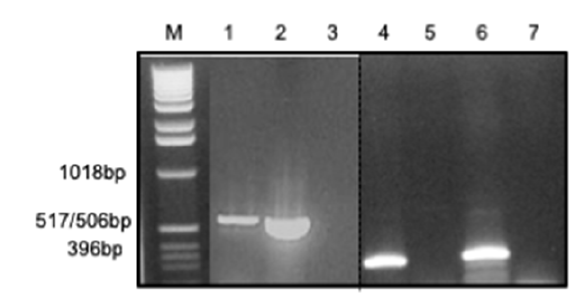
Figure 6. Electrophoresis of RT-PCR products after amplification of liver tissue with specific primers for CNF (left side) or β-actin (right side). M: molecular marker 1 kb DNA ladder (Gibco-BRL). Lanes 1 and 4: B. constrictor liver; lanes 2 and 6: C. d. terrificus liver (reference); lanes 3 and 7: negative control (no DNA); lane 5: no reverse transcriptase in the activity of C. d. terrificus venom by BcNF Figure 5. Inhibition curves of PLA 2 isolated from B. constrictor blood plasma (white dots). CNF from C. d. terrificus snakes was used as positive control for PLA inhibition (black dots). Curve 2 equations: y = (–1.344 ± 0.1705)x + (13.50 ± 0.4235) for BcNF, and y = (–4.797 ± 0.3434)x + (19.13 ± 0.4478) for CNF, with determination coefficient (R 2 ) of 0.8860 and 0.9606, respectively. The 95% confidence intervals of the best fit curves are indicated by dashed lines.